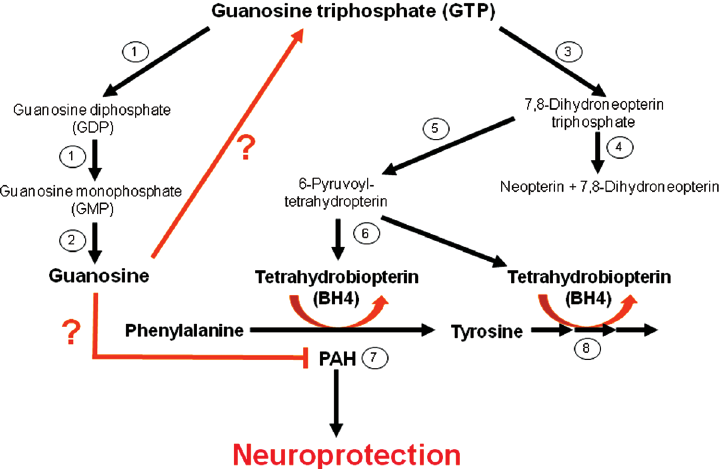
Figure 3 Schematic model of the sources of guanosine and other products derived from GTP. The purine nucleoside guanosine is the product of the stepwise dephosphorylation of guanosine triphosphate (GTP) to guanosine diphosphate (GDP) and guanosine monophos- phate (GMP) by ectonucleotide diphosphohydrolases (E-NTPDases, 1) and by ecto-5′-nucleotidase (2). In addition, GTP can be enzymatically cleaved by GTP-cyclohydrolase I (GCH-I, 3) to 7,8-dihydroneopterin triphosphate. Neopterin and 7,8-dihydroneopterin are then